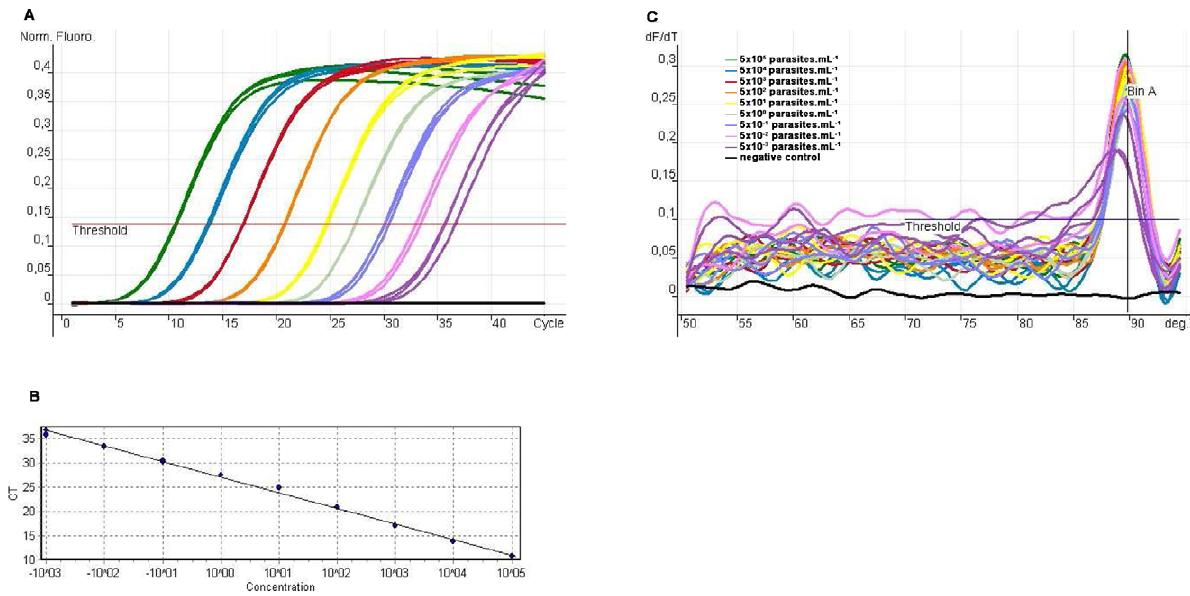
Figure 1. Standardization of qRT-PCR using the SYBR Green system. A) Standard amplification curve generated by10 fold serial dilutions of DNA from blood spiked with T. cruzi epimastigotes DNA (from 5.10 4 to 5.10 2 3 parasites/mL) and negative controls, threshold=0.12, efficiency=1.05. C) Linear regression curve and regression coefficient, R 2 =0.986. B) . Melting curve analysis of amplicons of samples represented in A: Tm=89.66 6 0.25 u C.